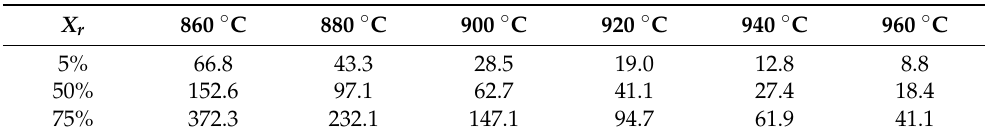
Table 2. Time required for different levels of SRX at different isothermal temperatures for Ti microal- loyed steel